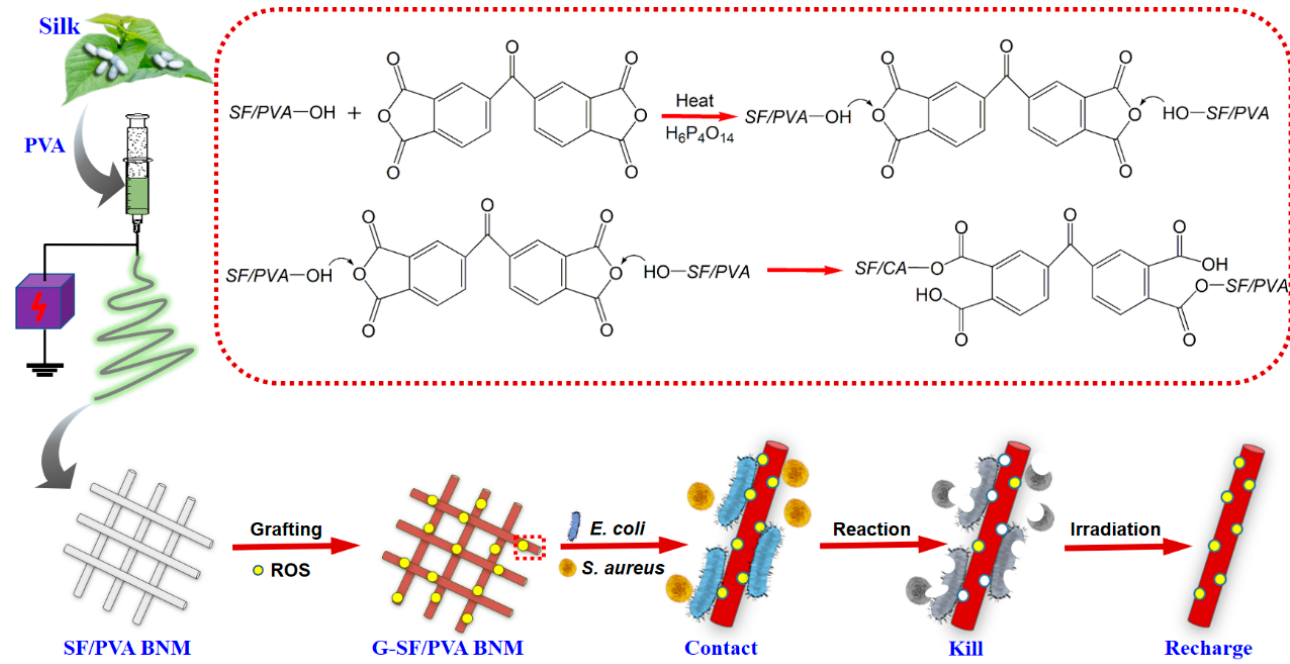
Figure 1. Scheme of the design, preparation, and antibacterial activity of G-SF/PVA BNM.